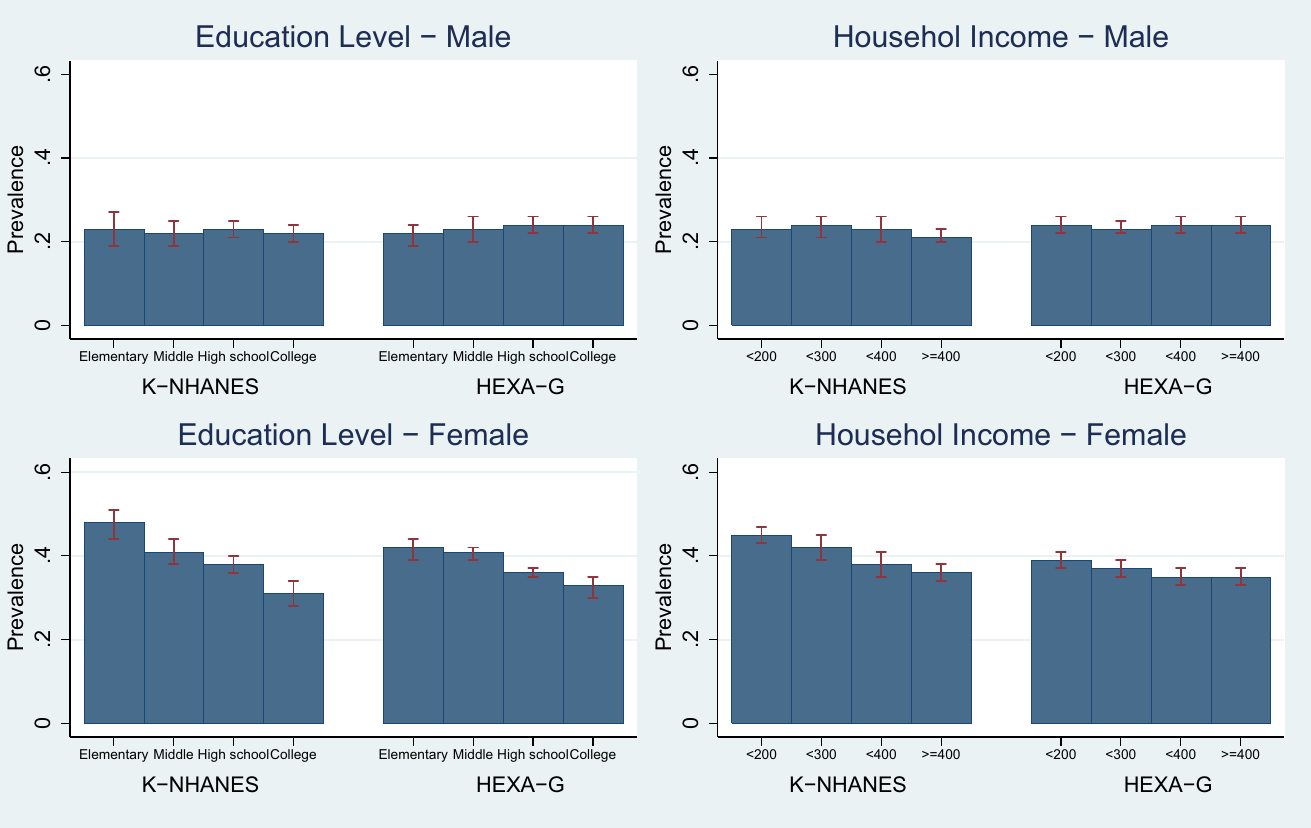
Fig 3. Age-standardized prevalence: Low HDL cholesterol. K-NHANES: Korea National Health and Nutrition Examination Survey; HEXA-G: Health Examinees- Gem. Low HDL cholesterol < 40 mg/dL (1.03 mmol/L) in males, < 50 mg/dL (1.29 mmol/L) in females or specific treatment for this lipid abnormality. (prevalence in K-NHANES: 0.50 [95%CI 0.47–0.53] for the lowest vs. 0.49 [95%CI 0.47–0.51] for the highest; HEXA-G: 0.51 [95%CI 0.47–0.56] vs. 0.51 [95%CI 0.48–0.55]). There was no socio- economic inequality for both K-NHANES and HEXA-G. The differences in prevalence between HEXA-G and K-NHANES were less than five percentage points (Fig 4, Table D in S1 File). Women. K-NHANES and HEXA-G showed women with the lower levels of education had higher prevalence of EBP than college graduates (prevalence in K-NHANES: 0.44 [95%CI 0.40–0.47] for elementary school vs. 024 [95%CI 0.21–0.27] for college graduates; HEXA-G: risk of EBP than those in high-income group (prevalence in K-NHANES 0.39 [95%CI 0.36–